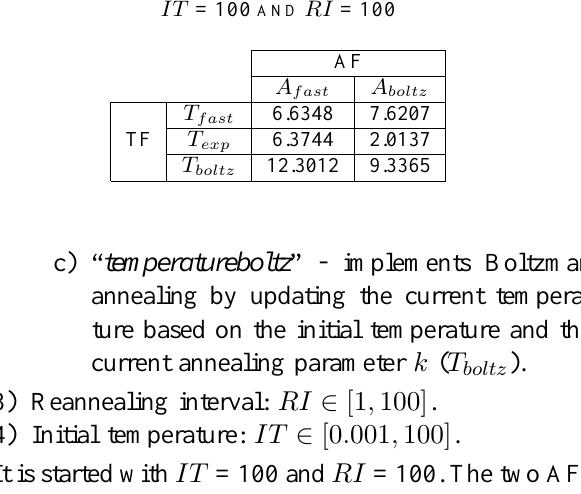
O BJECTIVE VALUES OBTAINED FOR DIFFERENT AF AND TF AT N UMERICAL RESULTS FROM PARAMETER IDENTIFICATION USING IT = 100 AND RI = 100